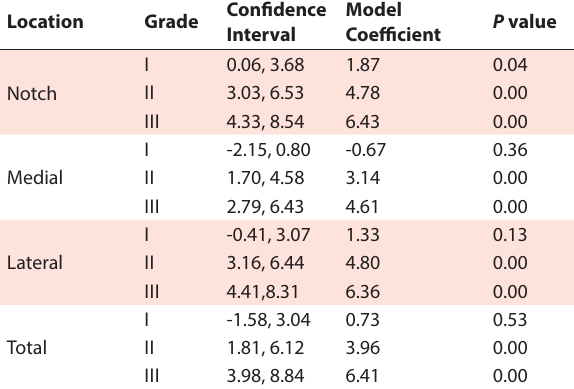
Table 1. Association between the trochlear cartilage grade and WOMAC pain index* Location